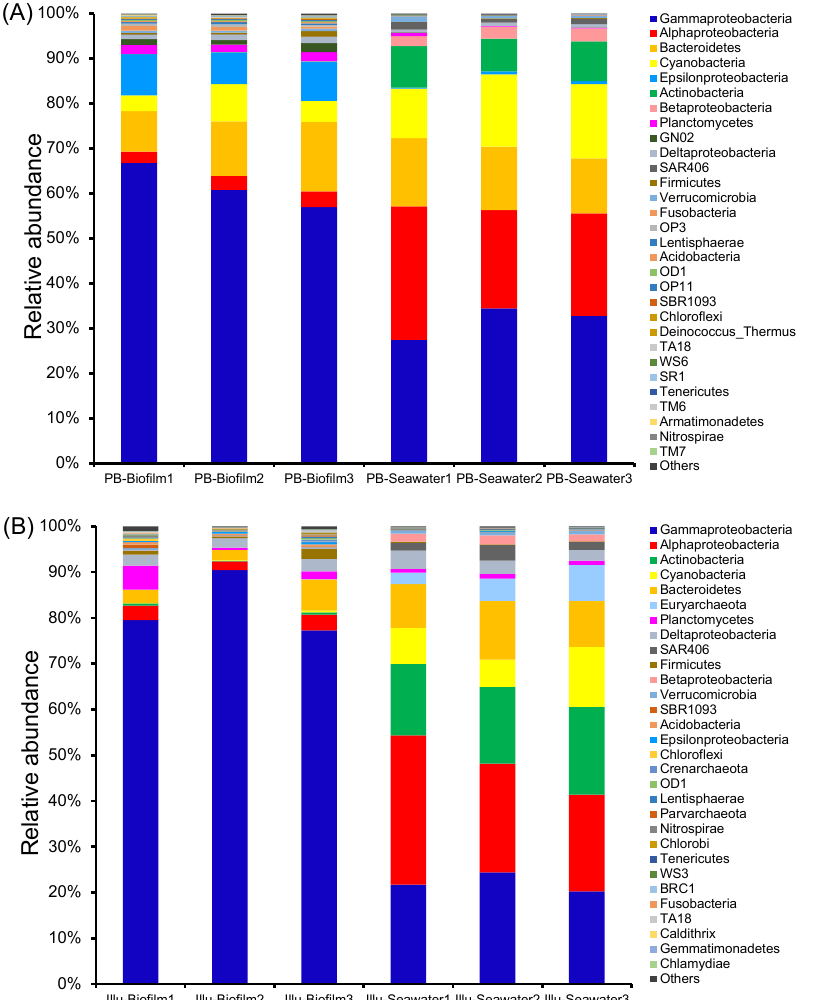
Figure 4. Phylum-level microbial community composition of the six samples. Proteobacteria were classified down to the class level. The 30 most abundant genera in terms of maximum relative abundance are shown, and the rest are merged into ‘Others’. ( A ) Biofilm and seawater microbial communities by PacBio sequencing. ( B ) Biofilm and seawater microbial communities by Illumina sequencing.